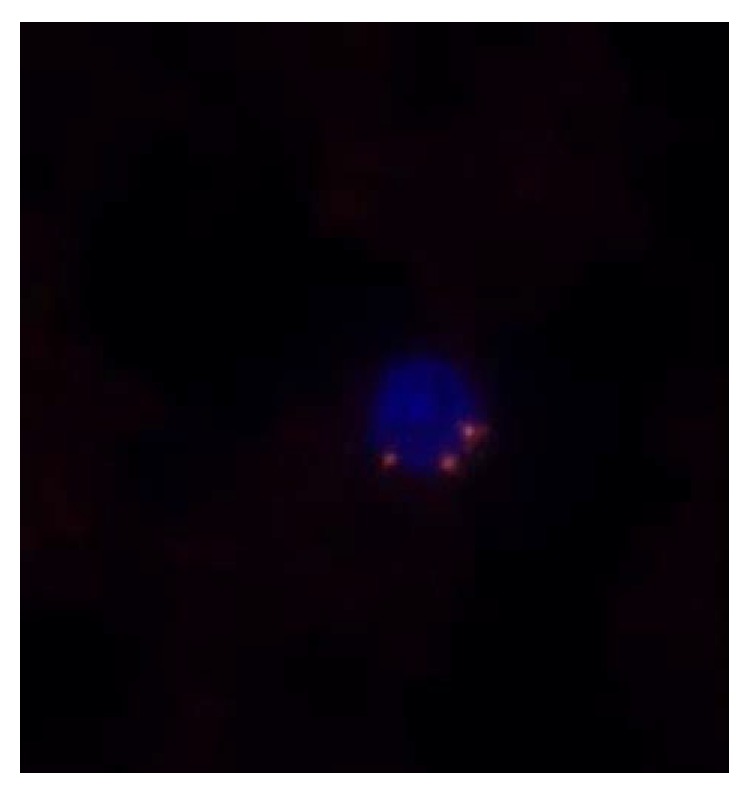
Immunostaining of a single lung cancer CTC isolated from patient peripheral blood. The CTCs were observed through combining CD45, DAPI, and fluorescence in situ hybridization with the centromere of chromosome 8 (CEP8). CD45-DAPI+CEP8>2 was considered as CTC.